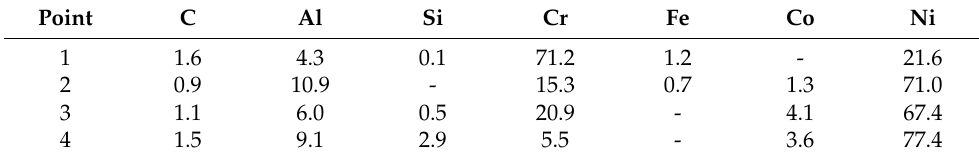
Figure 16. Photograph of the turbine blade metallographic section with SEM image after fatigue testing at 950 ◦ C. Table 3. Chemical analysis of the fractured